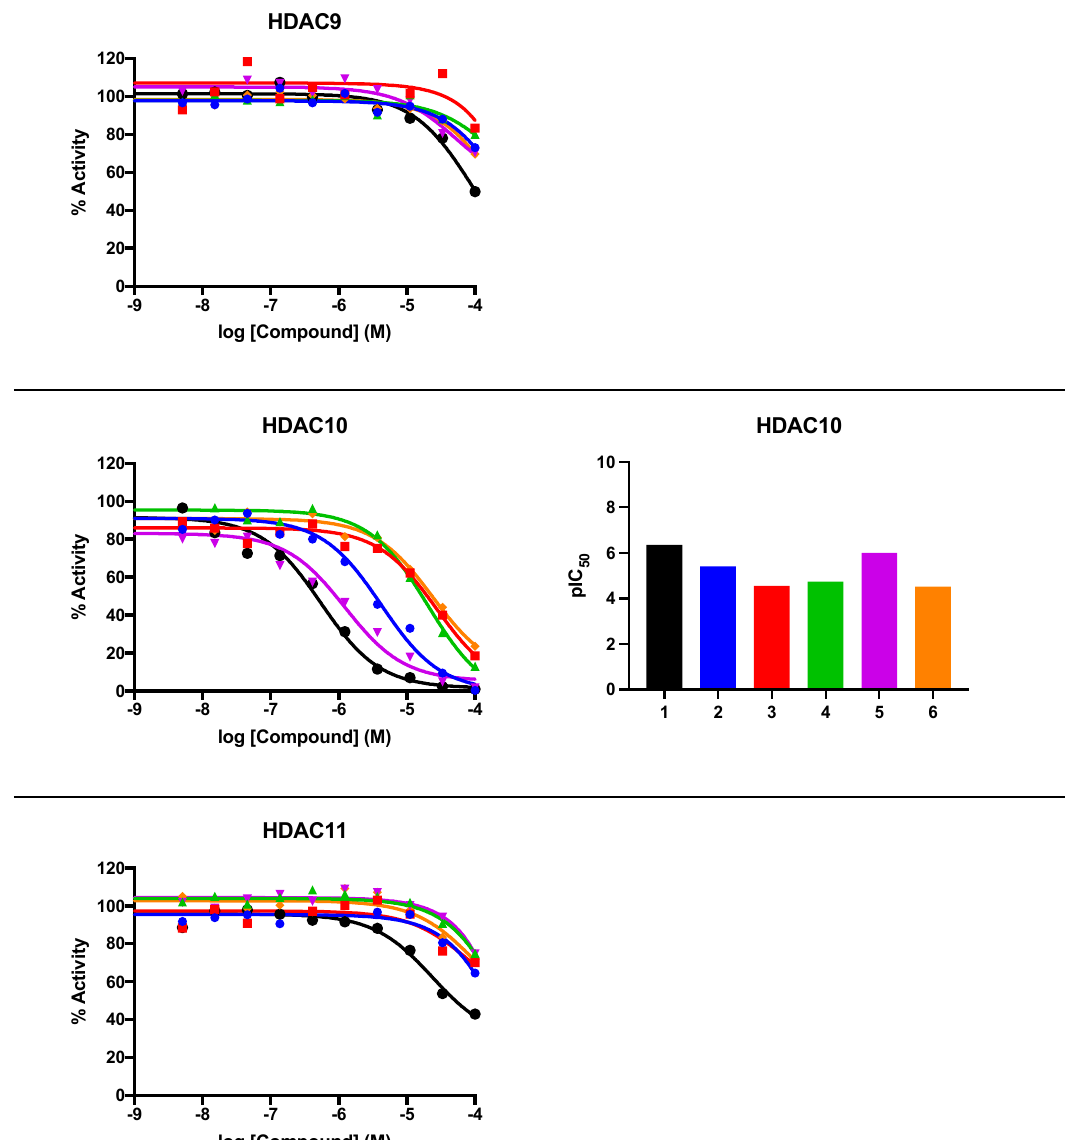
Figure 2. HDAC inhibitory activity of SAHA analogs. Black = 1 ; blue = 2 ; red = 3 ; green = ( ± )- 4 ; magenta = 5 ; orange = 6 . Histograms of pIC 50 values (right column) are provided only where the inhibition is significant.